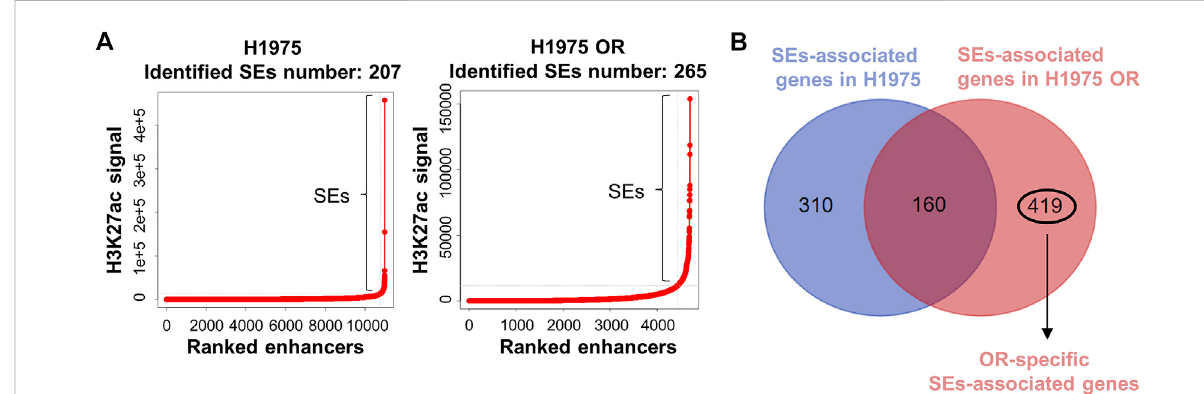
FIGURE 3 OR-speci fi cSEs wereidenti fi ed. (A) Dot plots show H3K27acread coverage of distalenhancersinindicated cells. A totalof207 SEsand 265SEs were identi fi ed above a fl ex-point (slope > 1) in H1975 cells and H1975 OR cells. (B) Venn diagram shows the intersection of SEs-associated genes in H1975 cells and H1975 OR cells. OR-speci fi c SEs-associated genes were marked.